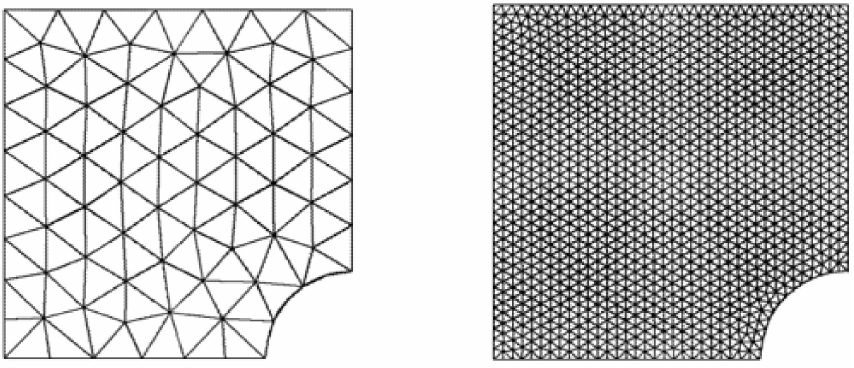
Figure 6. Plate with rigid circular inclusion domain. Table 8. Error in Stress (L 2 -Norm) and global effectivity ( θ ) in compressible elastic square plate with circular inclusion example considering displacement and stress recovery